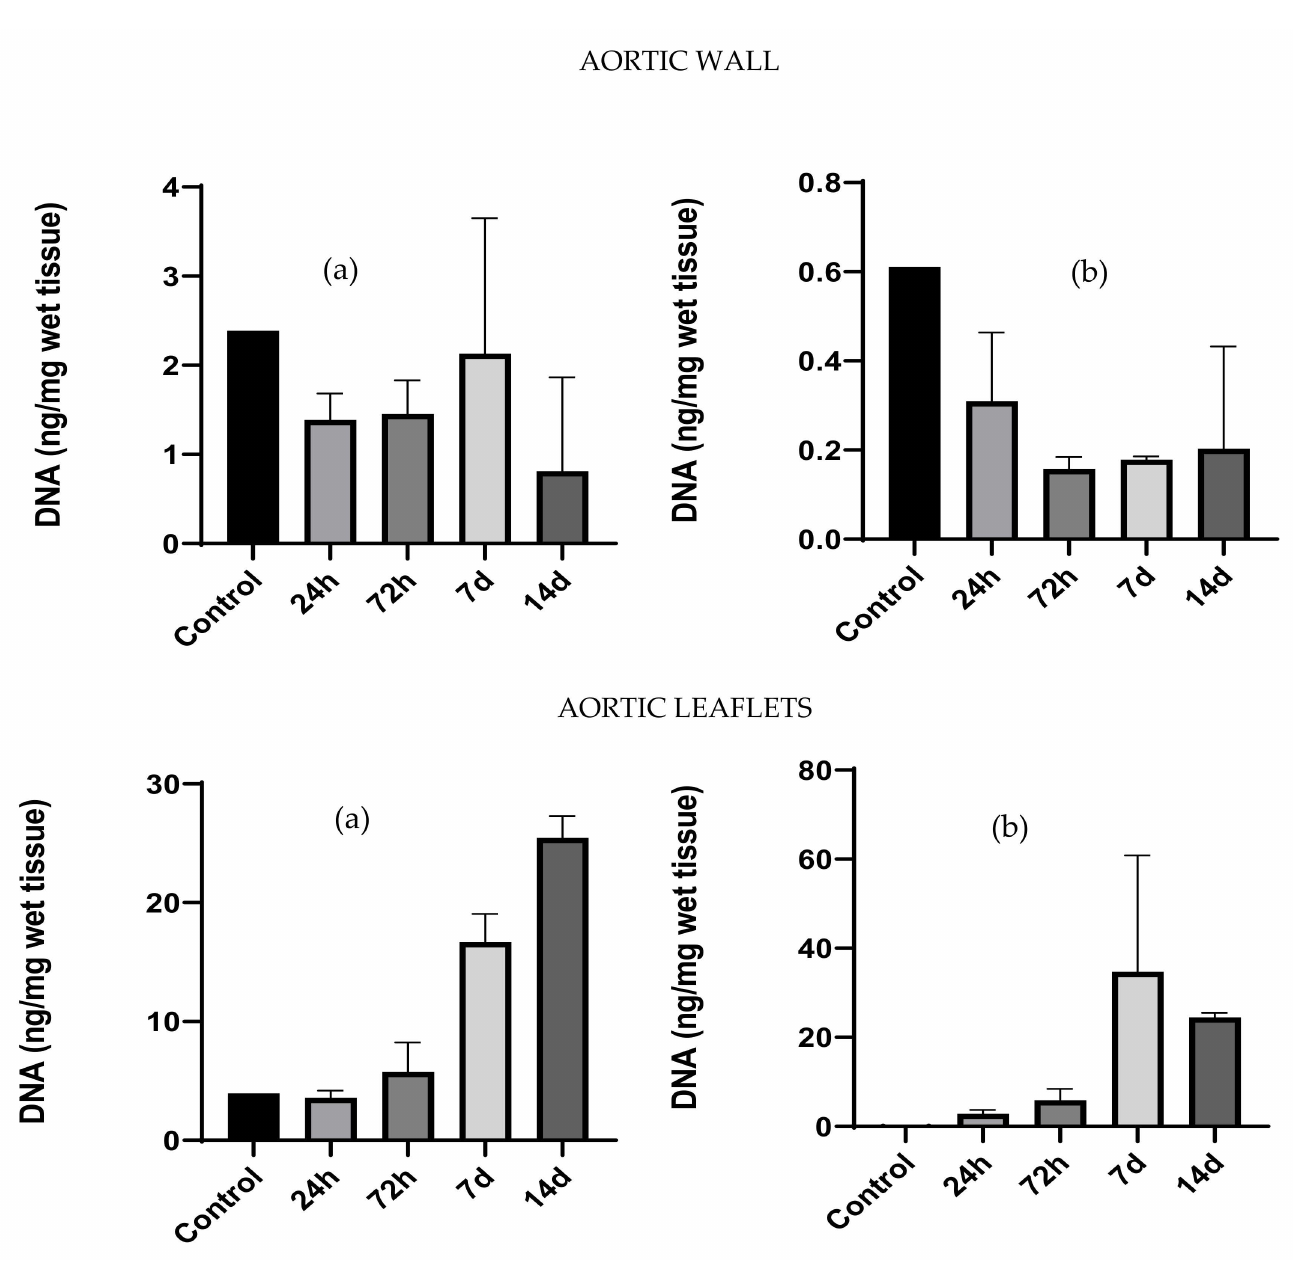
Figure 9. DNA quantification (ng/mg of dry tissue) comparative analysis between native and decellularized tissues performed by Nanodrop ( a ) and Qubit assay ( b ). Data were analyzed by one-way ANOVA ( p < 0.05). There was a significant difference between native and corresponding decellularized